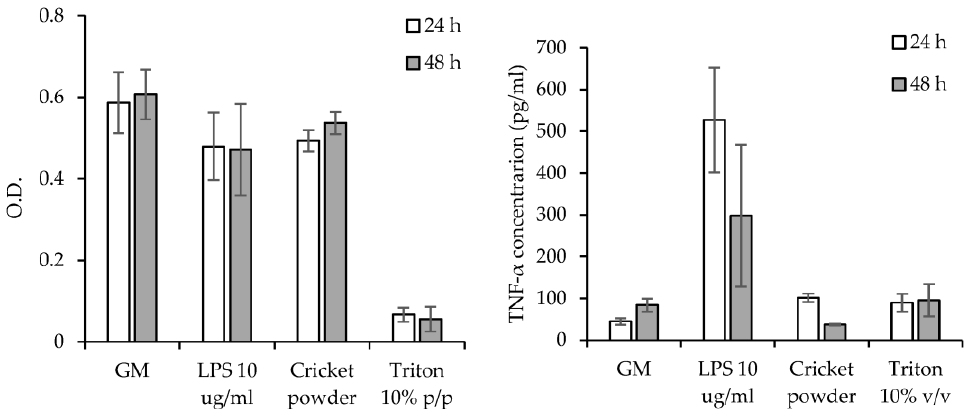
Figure 7. Cytocompatibility of macrophages (O.D.—optical density) after one and two days of contact with SD cricket extract ( left panel ), and TNFα cytokine expression and concentrations (pg/mL) for cells exposed to SD cricket extract ( right panel ) (mean values ± sd; n = 8). Anova one-way, Scheffé